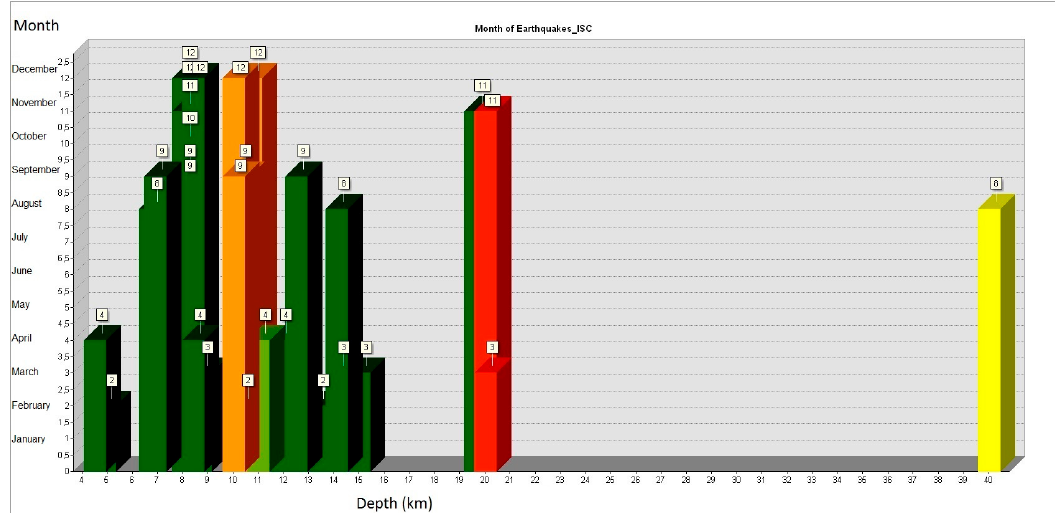
Figure 5. Monthly distribution of earthquake occurrence with respect to depth (yellow, magnitude 4; green; magnitude 5; red, magnitude >5.